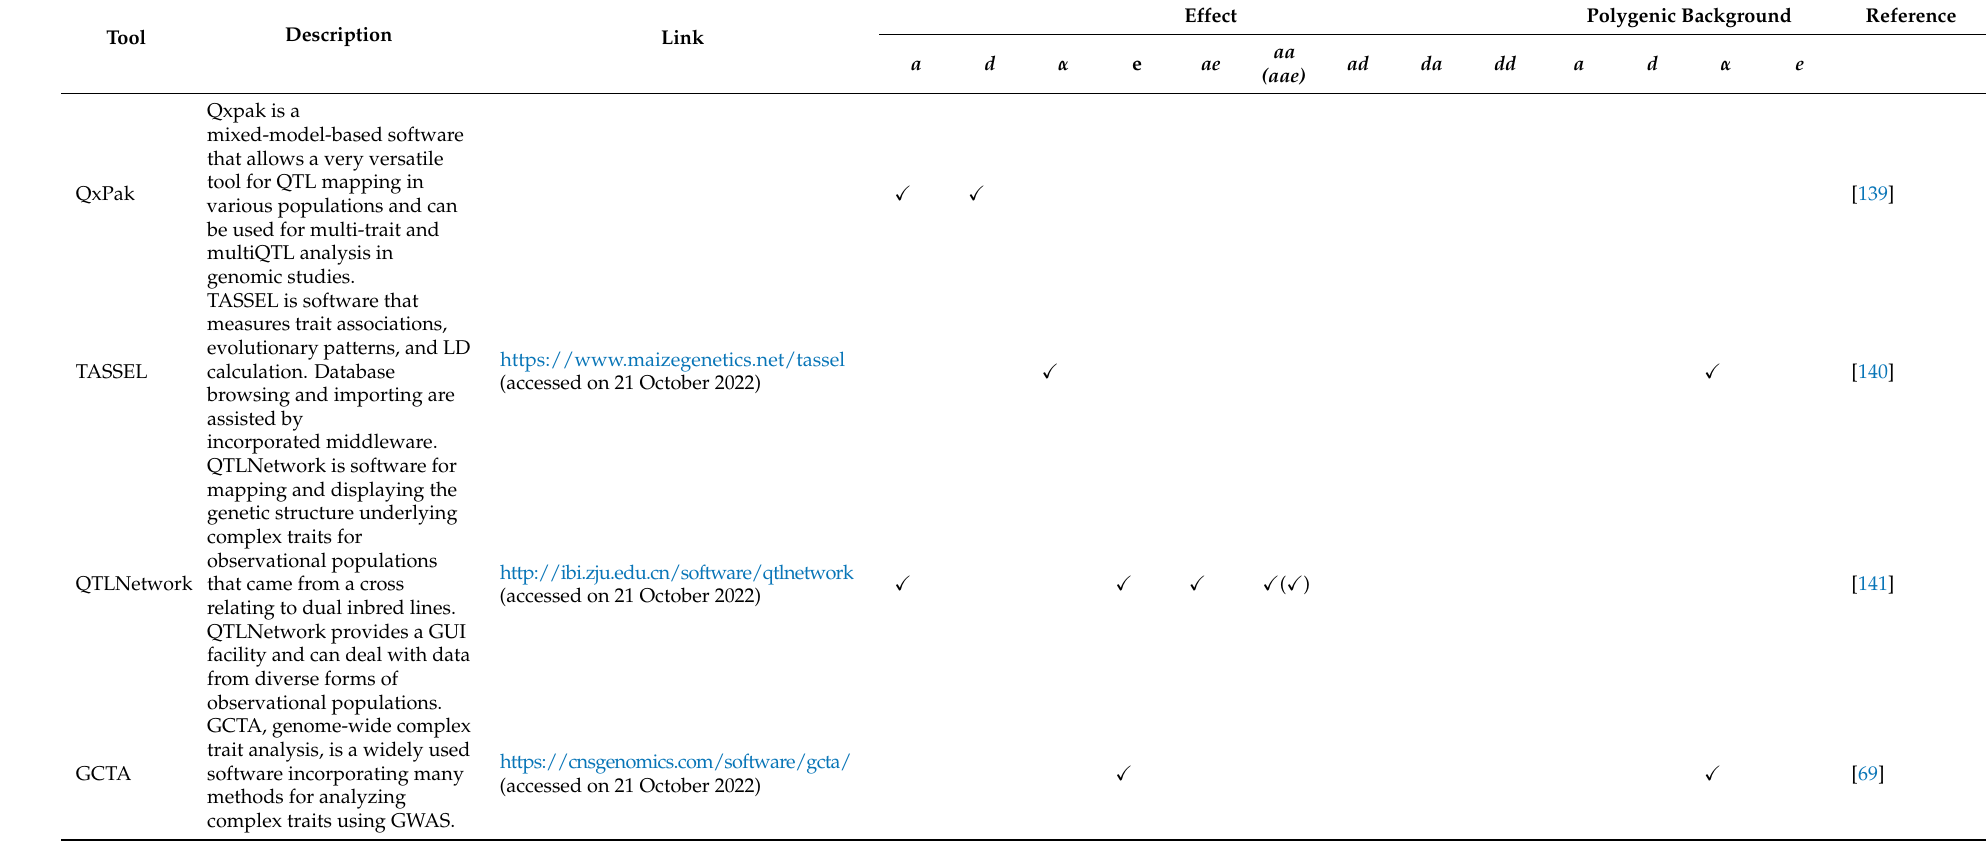
Table 7. Web software and server-based tools using